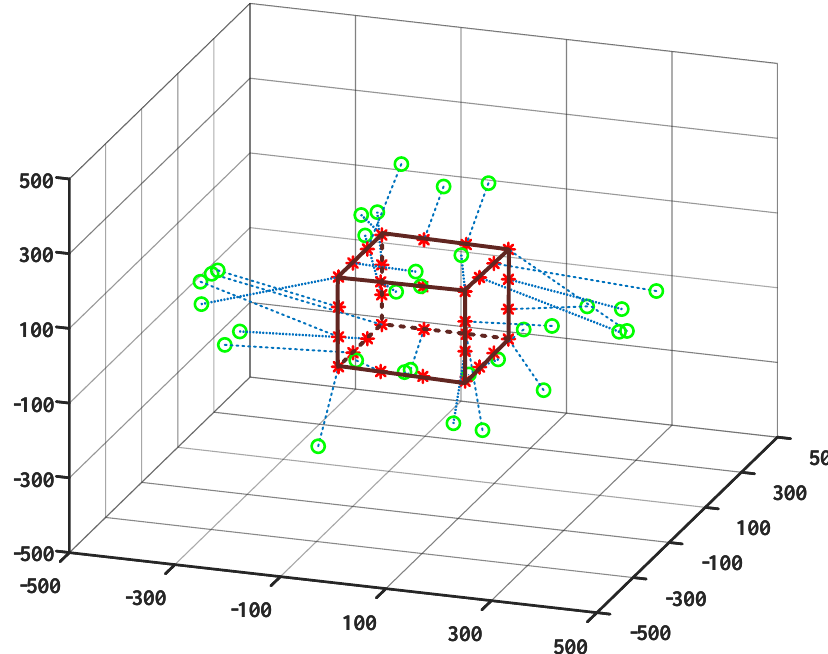
Figure 7. The side perspective of topology shaping in cube